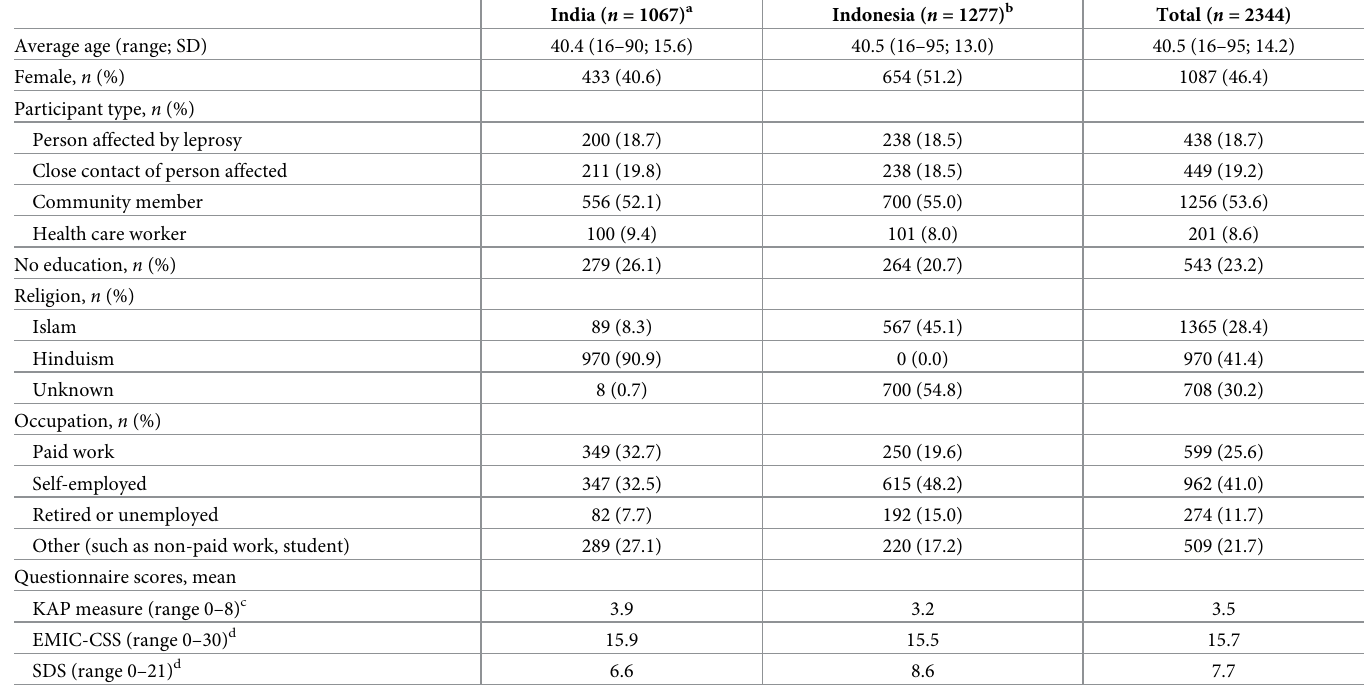
Table 1. Socio-demographic characteristics and leprosy-related stigma and knowledge